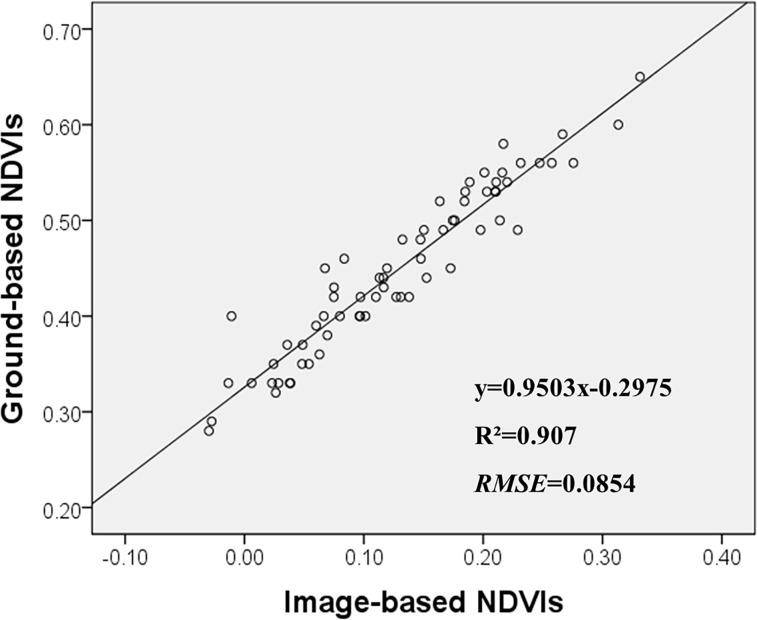
Correlation between image-based NDVIs and ground-based NDVIs on Aug 30th.